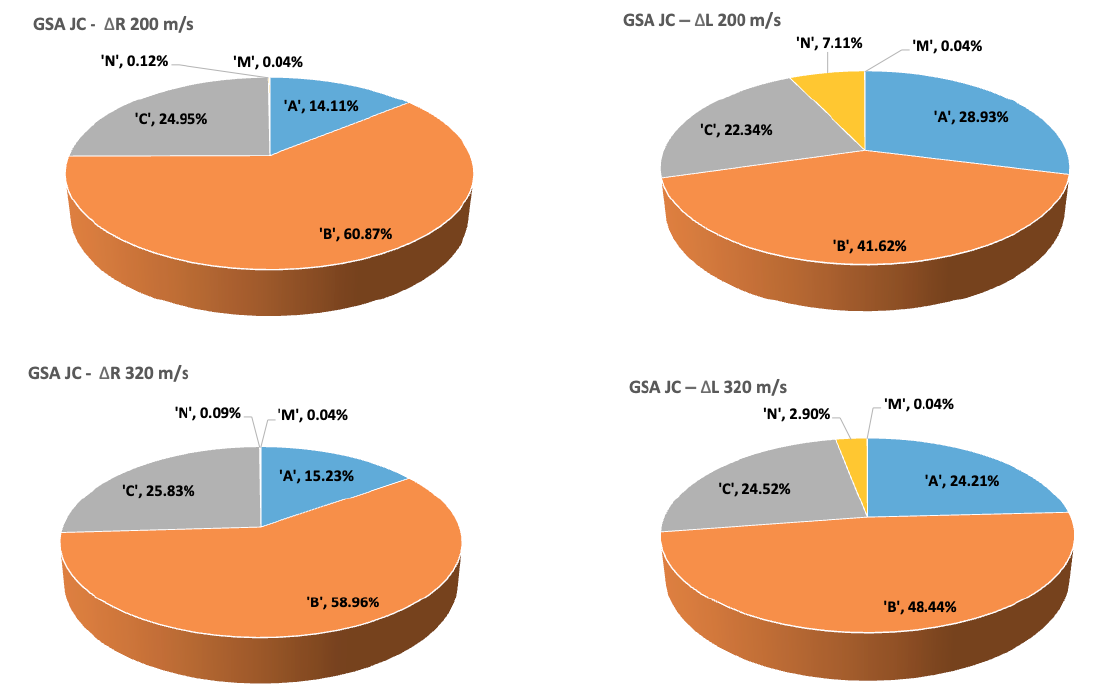
Figure 7. Global Sensitivity Analysis (GSA) results for the Johnson–Cook (JC) model considering ∆ R and ∆ L at 200 and 320